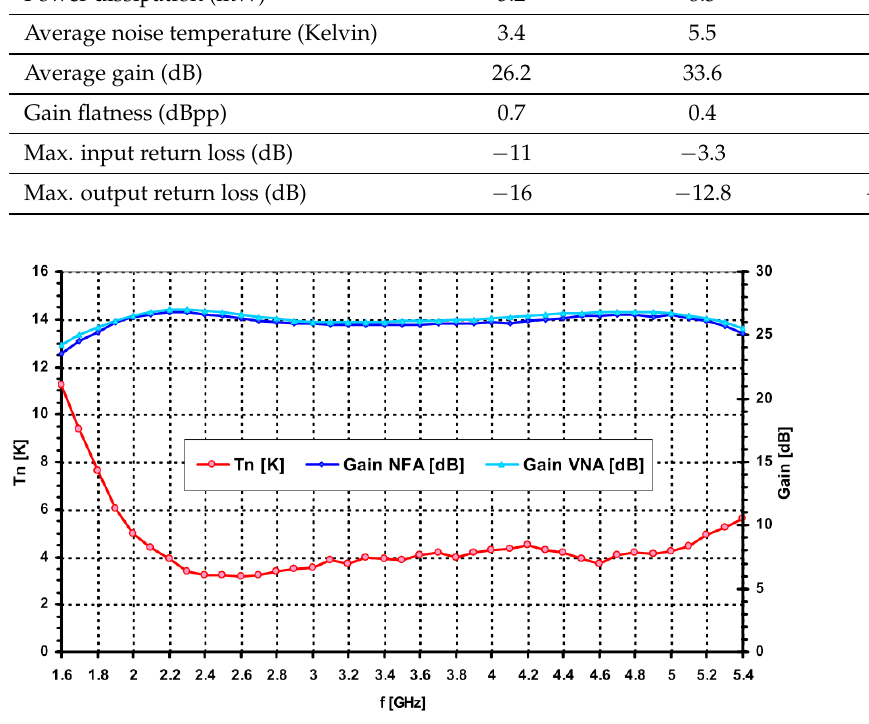
Figure 10. Gain and noise temperature plots of the S-band LNA at 14 Kelvin ambient